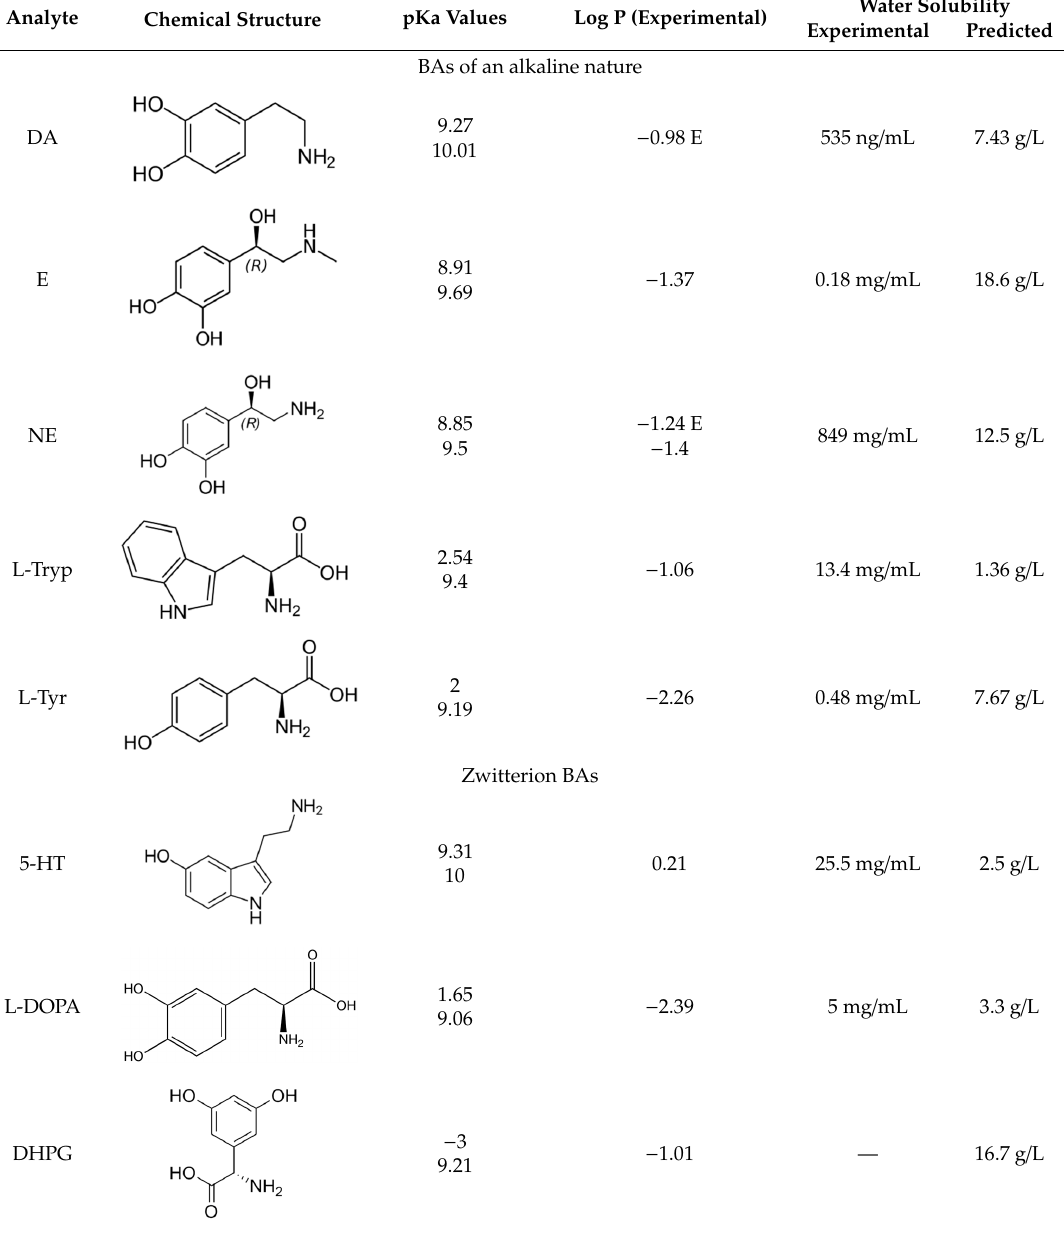
Table 1. Classification of selected BAs on the basis on physicochemical parameters.